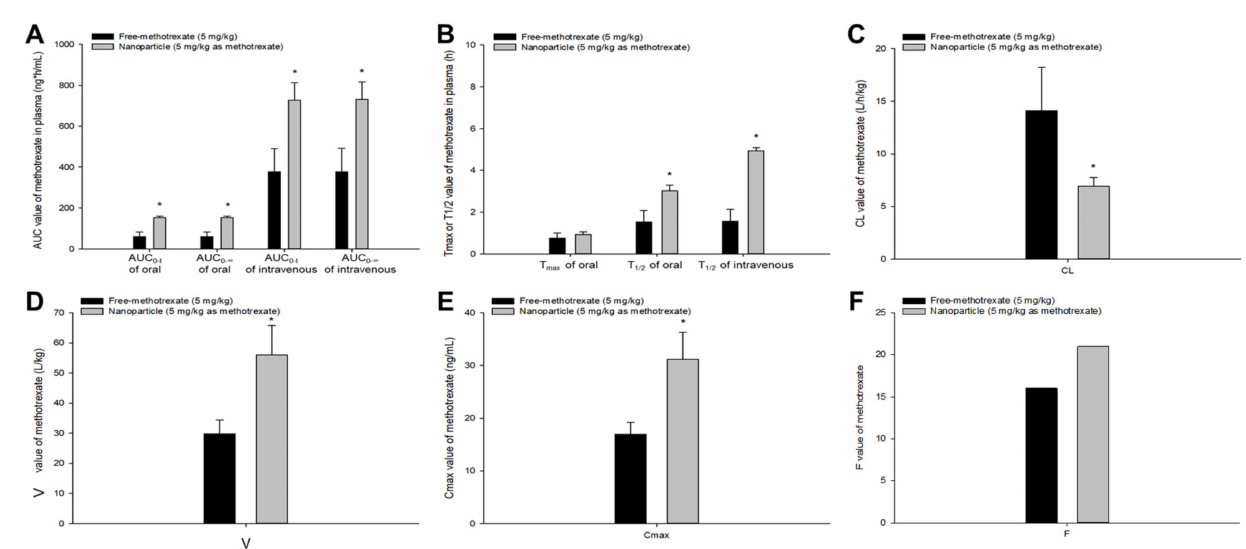
Figure 1. Mean pharmacokinetic parameters ( A ), AUC 0-t and AUC 0- ∞ ; ( B ), T max and T 1/2 ; ( C ), CL; ( D ), V; ( E ), C max ; ( F ), F of methotrexate after oral or intravenous administration of free methotrexate solution (black box, 5 mg/kg) and methotrexate-loaded nanoparticles (gray box, 5 mg/kg as methotrexate) in rats. Vertical bars represent standard deviation of the mean ( n = 5). * p < 0.05 compared with the administration of free-methotrexate.